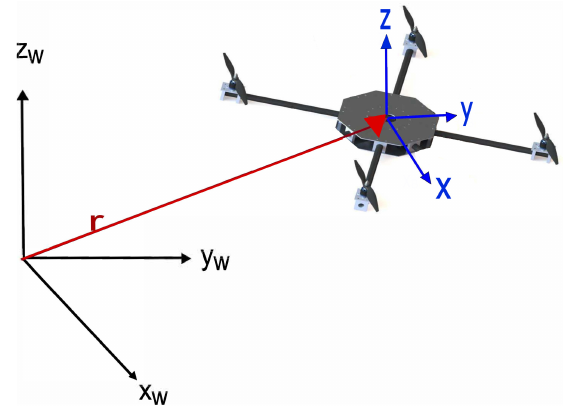
Figure 1. The QUAV and the reference